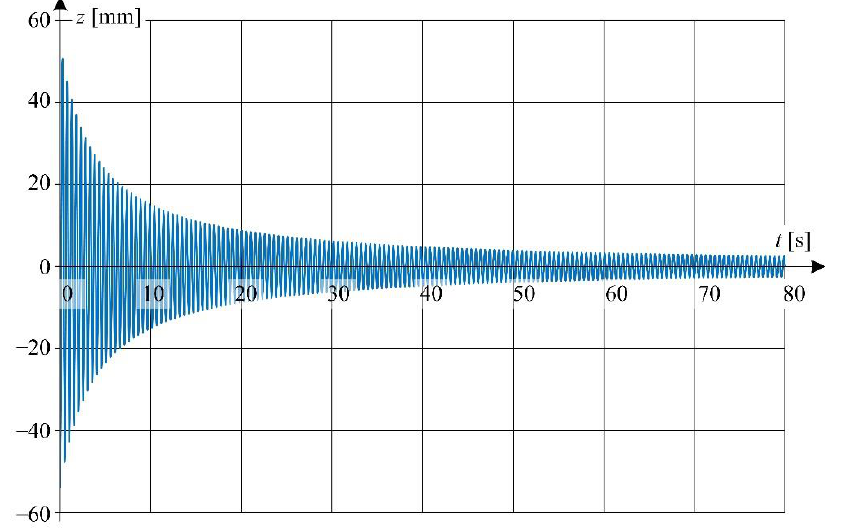
( b ) for 20 to 30 s of oscillation time.